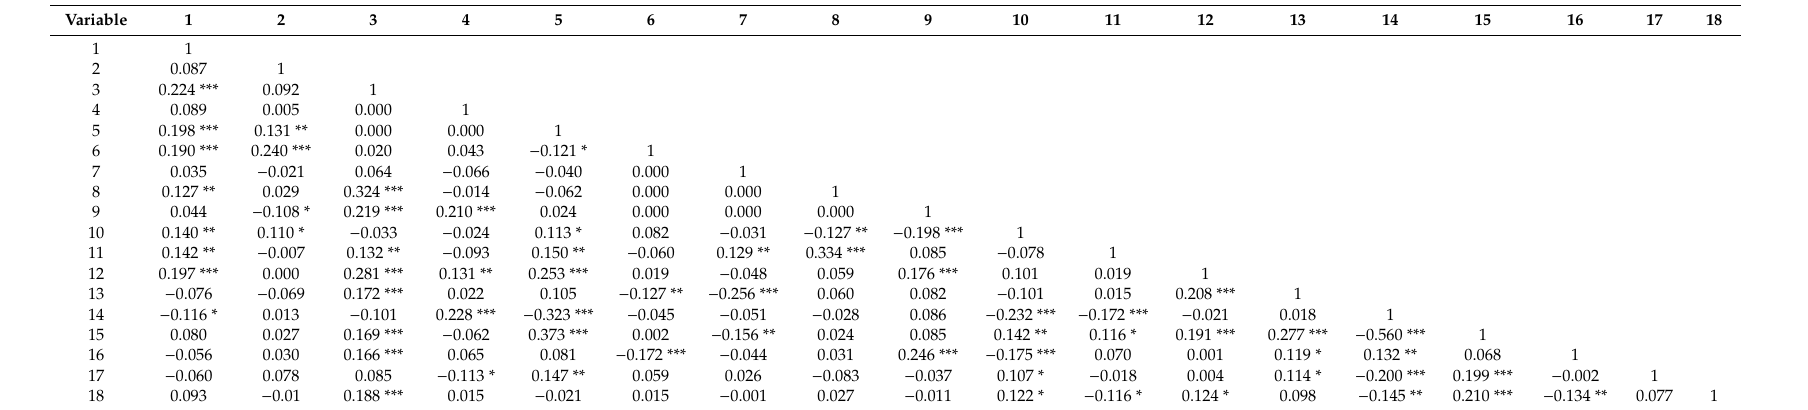
Table 7. Correlation coe ffi cient matrix of variables in the